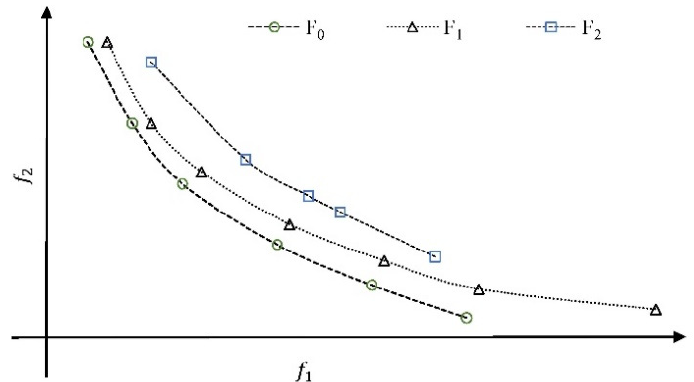
Figure 7. Crowding distance calculation for individual i . f 1 and f 2 represent two objectives. Filled circles show the individuals’ fitness of the same non-dominated front F 0 .